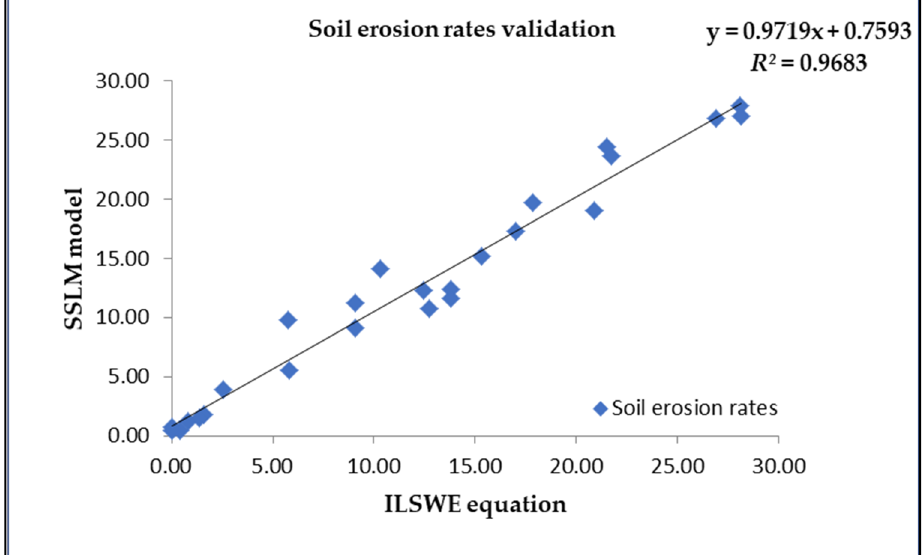
Figure 17. Linear relationship between the ILSWE model and the proposed model (SSLM).